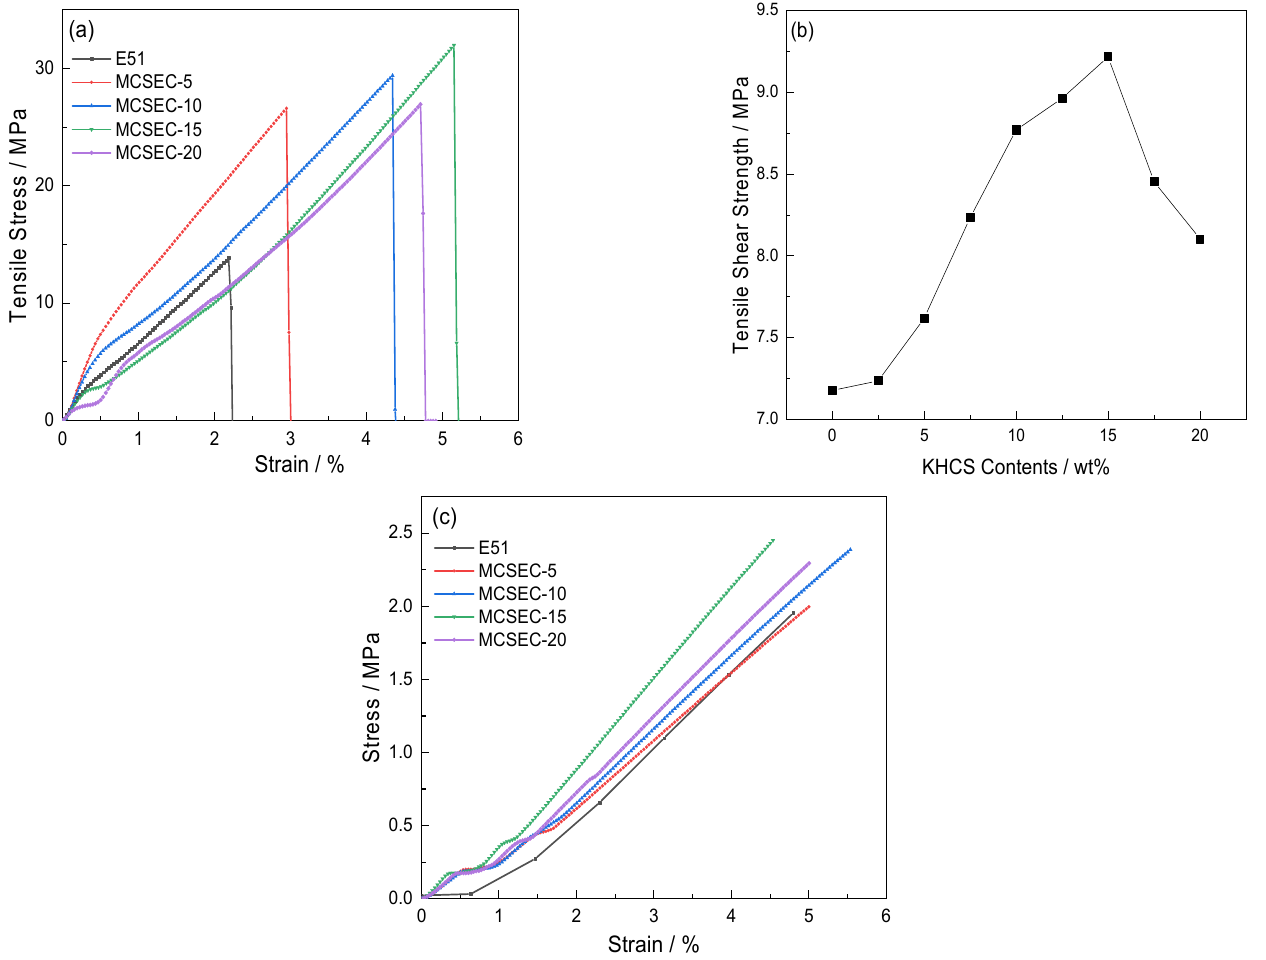
Figure 8. Tensile and bending curves of MCSEC: ( a ) Tensile stress-strain curve; ( b ) Tensile shear strength; ( c ) Flexural stress-strain curve.